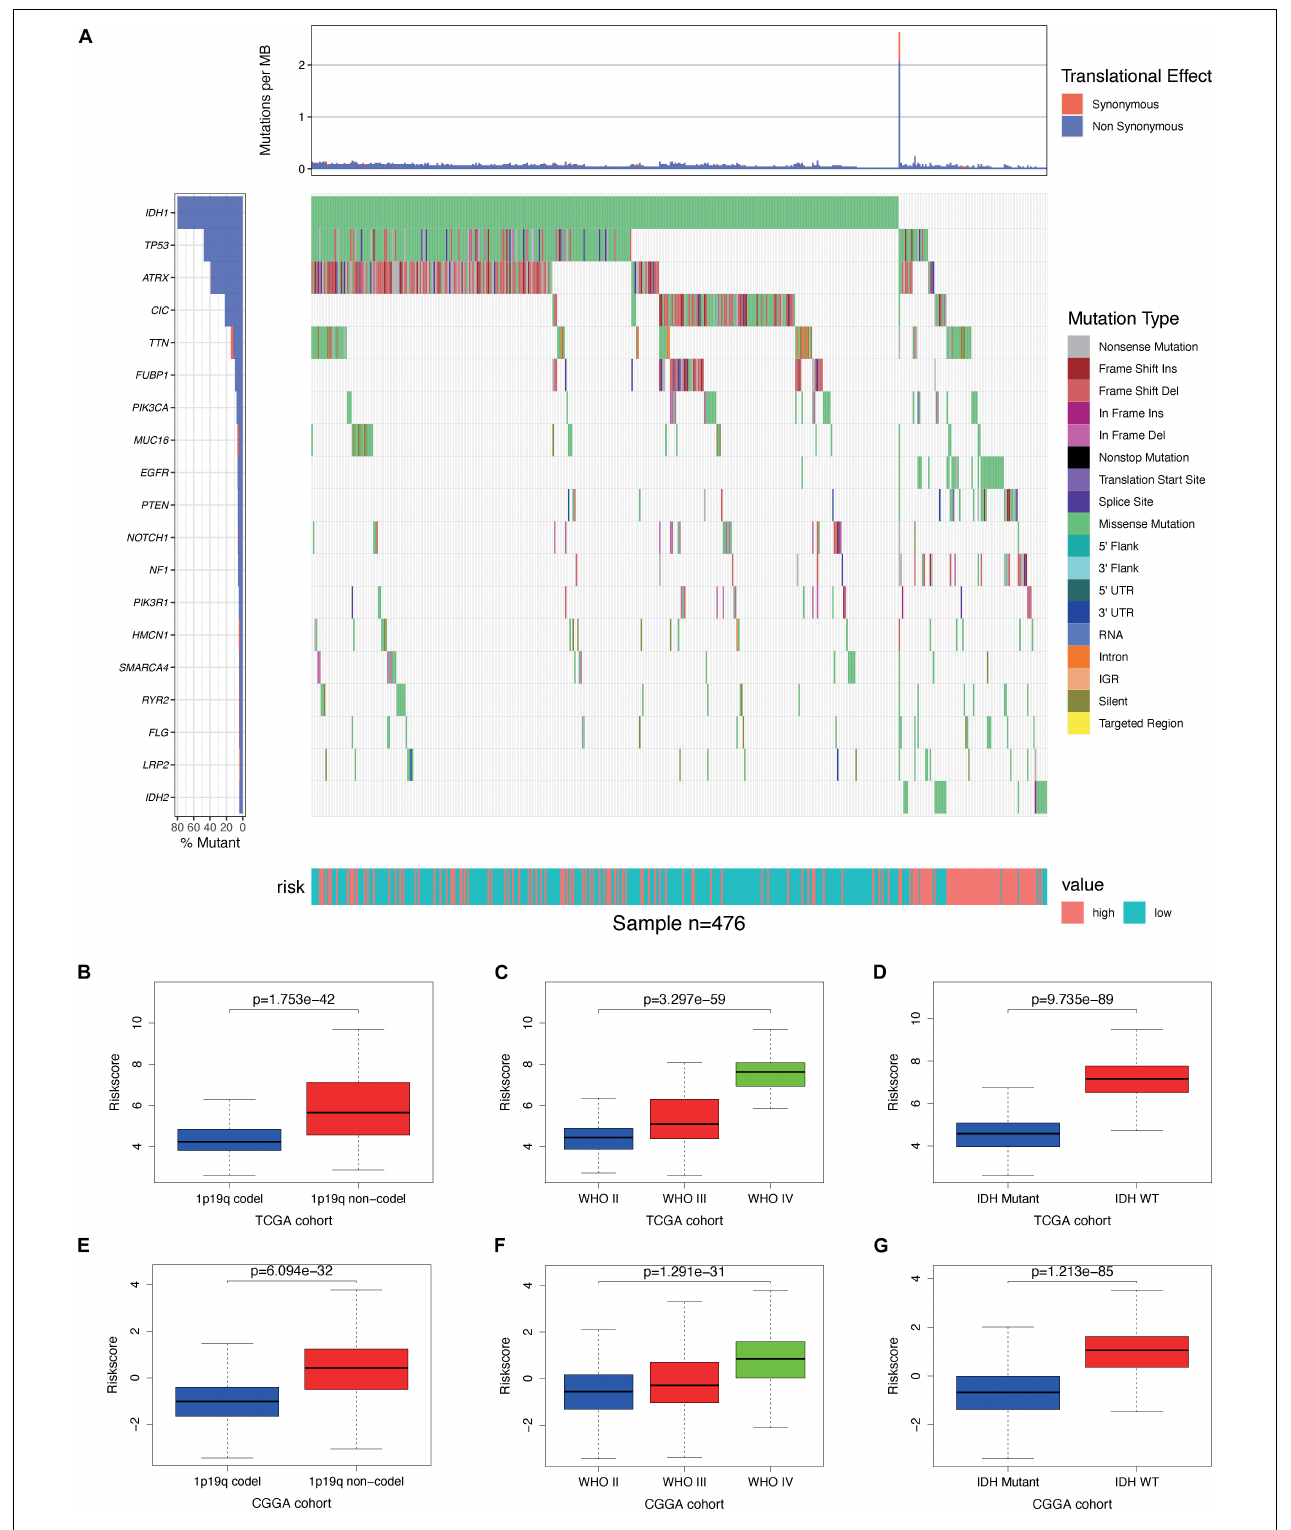
FIGURE 8 | Association between genomic alterations, pathologic characteristics, and the autophagy-related signature. (A) Differential somatic mutation analysis between high-risk group and low-risk group in The Cancer Genome Atlas (TCGA) cohort. (B–D) Distribution of the risk score in glioma patients stratified by 1p/19q codeletion status, WHO grade, and isocitrate dehydrogenase (IDH) mutation status in TCGA cohort. (E–G) Distribution of the risk score in glioma patients stratified by 1p/19q codeletion status, WHO grade, and IDH mutation status in the Chinese Glioma Genome Atlas (CGGA) cohort.